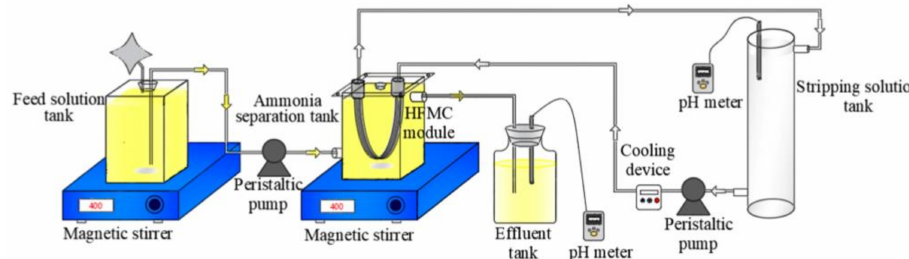
Figure 6. Schematic diagram of the hollow fiber membrane contactor set-up